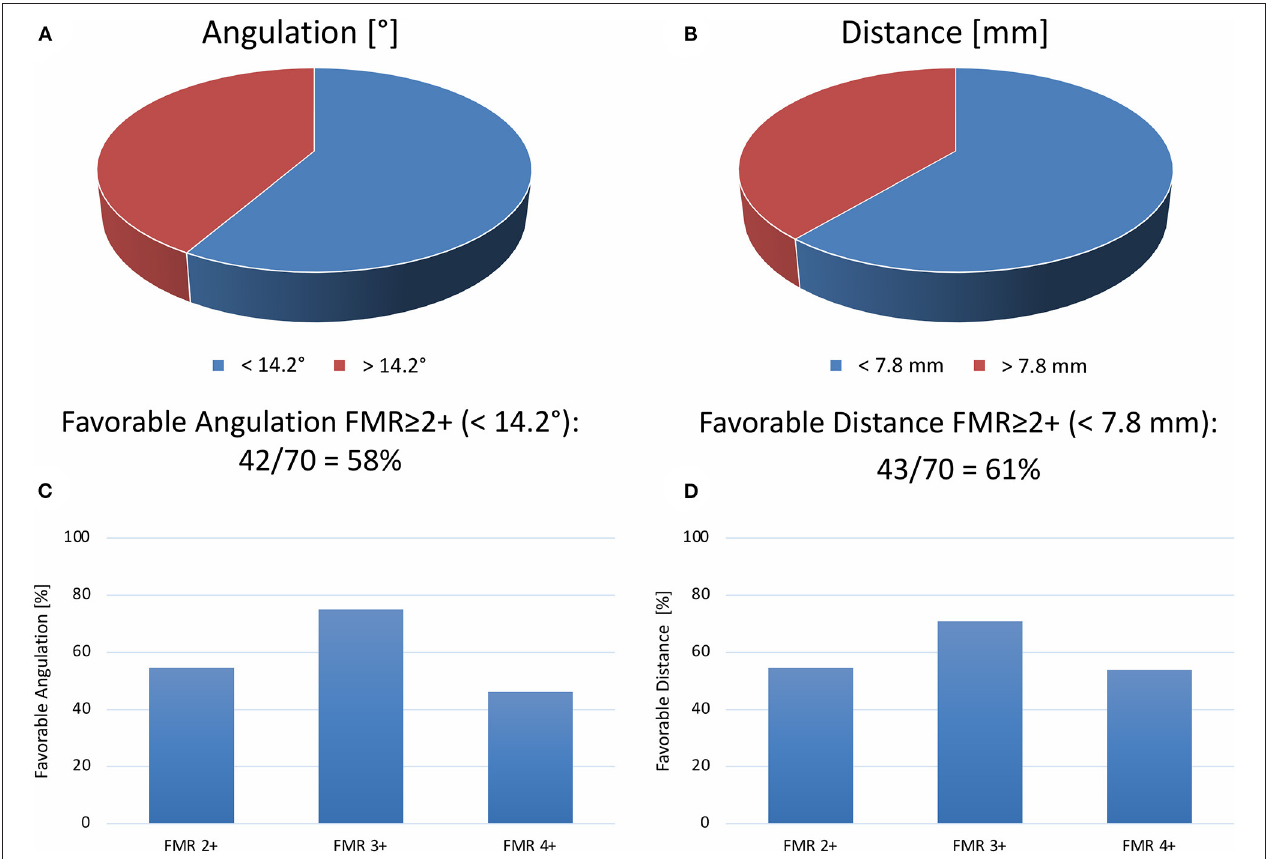
FIGURE 6 | Topography of coronary sinus to mitral valve annulus for percutaneous sinus-based mitral valve annuloplasty. Percentage of patients with favorable angle [ < 14.2 ◦ , (A) ] or distance [ < 7.8mm, (B) ] of the coronary sinus to the mitral valve annulus. Percentage of favorable angle (C) or distance (D) according to FMR ≥ 2 + classes (FMR2 + , FMR3 + , or FMR4 +